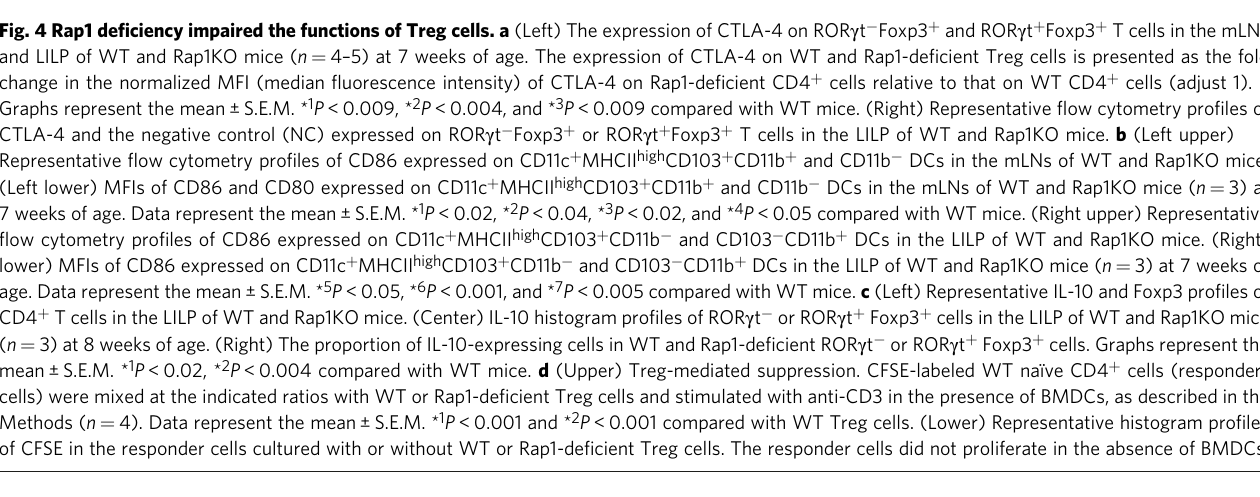
Fig. 4 Rap1 de fi ciency impaired the functions of Treg cells. a (Left) The expression of CTLA-4 on ROR γ t − Foxp3 + and ROR γ t + Foxp3 + T cells in the mLNs and LILP of WT and Rap1KO mice ( n = 4 – 5) at 7 weeks of age. The expression of CTLA-4 on WT and Rap1-de fi cient Treg cells is presented as the fold change in the normalized MFI (median fl uorescence intensity) of CTLA-4 on Rap1-de fi cient CD4 + cells relative to that on WT CD4 + cells (adjust 1). Graphs represent the mean ± S.E.M. * 1 P < 0.009, * 2 P < 0.004, and * 3 P < 0.009 compared with WT mice. (Right) Representative fl ow cytometry pro fi les of CTLA-4 and the negative control (NC) expressed on ROR γ t − Foxp3 + or ROR γ t + Foxp3 + T cells in the LILP of WT and Rap1KO mice. b (Left upper) Representative fl ow cytometry pro fi les of CD86 expressed on CD11c + MHCII high CD103 + CD11b + and CD11b − DCs in the mLNs of WT and Rap1KO mice. (Left lower) MFIs of CD86 and CD80 expressed on CD11c + MHCII high CD103 + CD11b + and CD11b − DCs in the mLNs of WT and Rap1KO mice ( n = 3) at 7 weeks of age. Data represent the mean ± S.E.M. * 1 P < 0.02, * 2 P < 0.04, * 3 P < 0.02, and * 4 P < 0.05 compared with WT mice. (Right upper) Representative